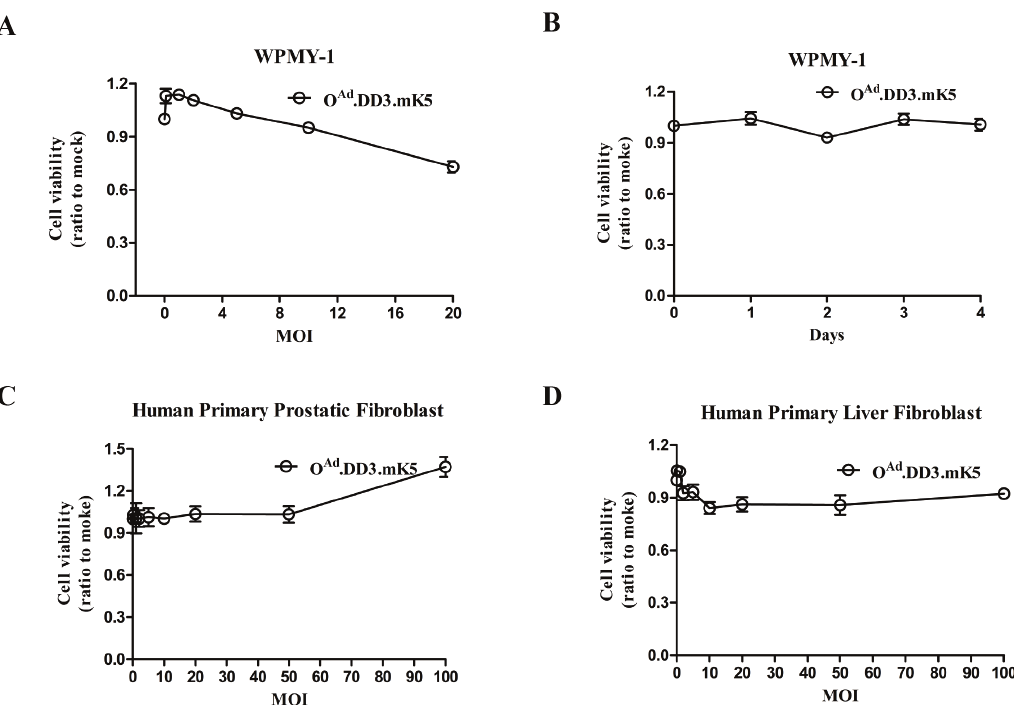
Figure 4: Safety measure of O Ad .DD3.mK5. A. Cell viability of WPMY-1 cell infected with O Ad .DD3.mK5 at a series of MOIs on day 4. B. Cell viability of WPMY-1 cell infected with O Ad .DD3.mK5 at 10MOI for 4 days. C-D. Cell viability of human primary prostatic fibroblast and human primary liver fibroblast cells infected with O Ad .DD3.mK5 at various MOIs on day 4. All date were repeated three times. The bars represent the mean ± S.D. (n = 3).